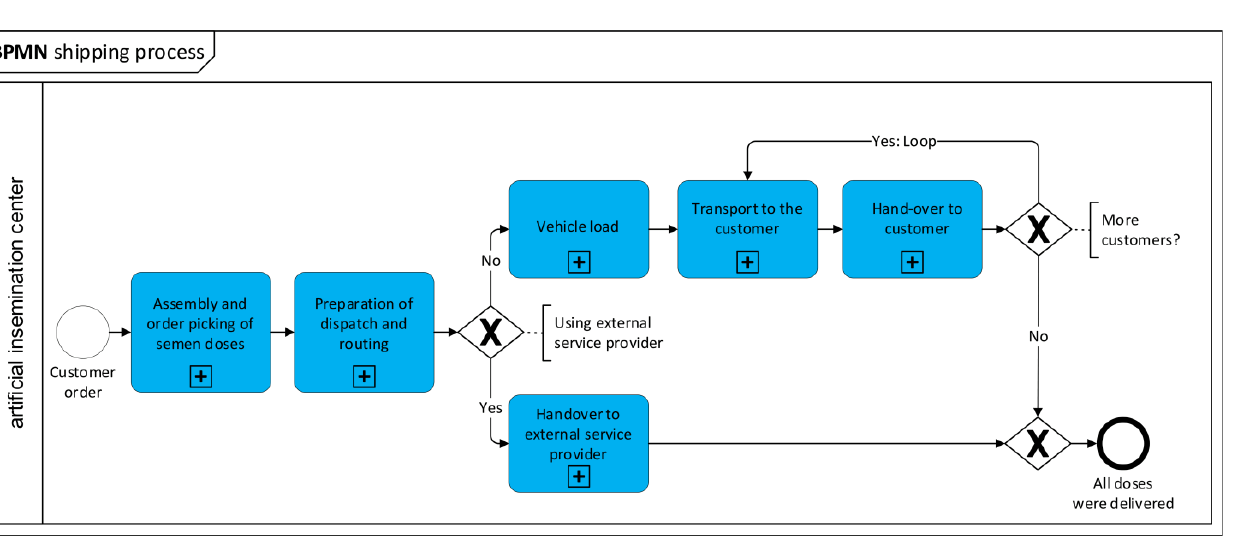
Figure 1. Overview of sub- processes of the business process “shipping of boar semen”, visualized using Business Process Model and Notation (BPMN).